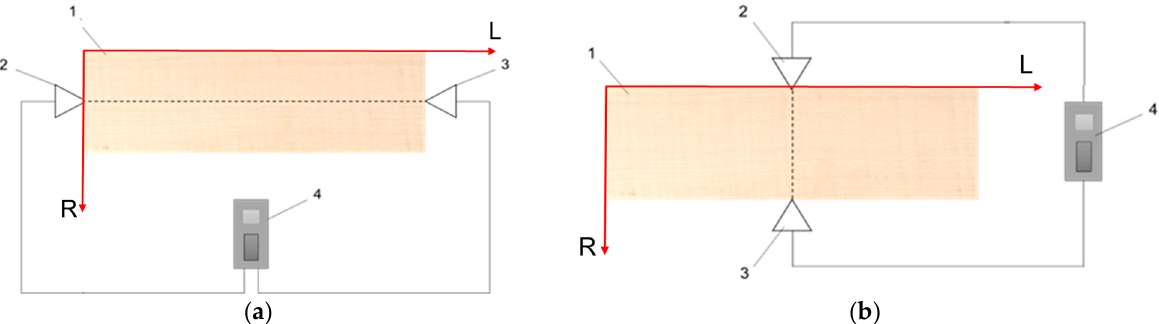
Figure 4. Measuring the sound velocity in wood: ( a ) in the longitudinal direction; ( b ) in the radial direction. Legend: 1–sample; 2–transmitter; 3–receiver; 4–US transmitter; acquisition and displayed data device.